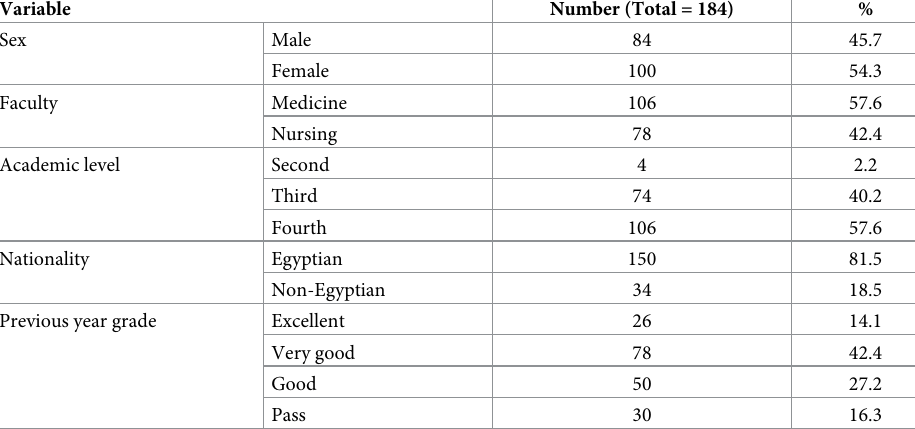
Table 1. Basic characteristics of the included medical and nursing students in Cairo